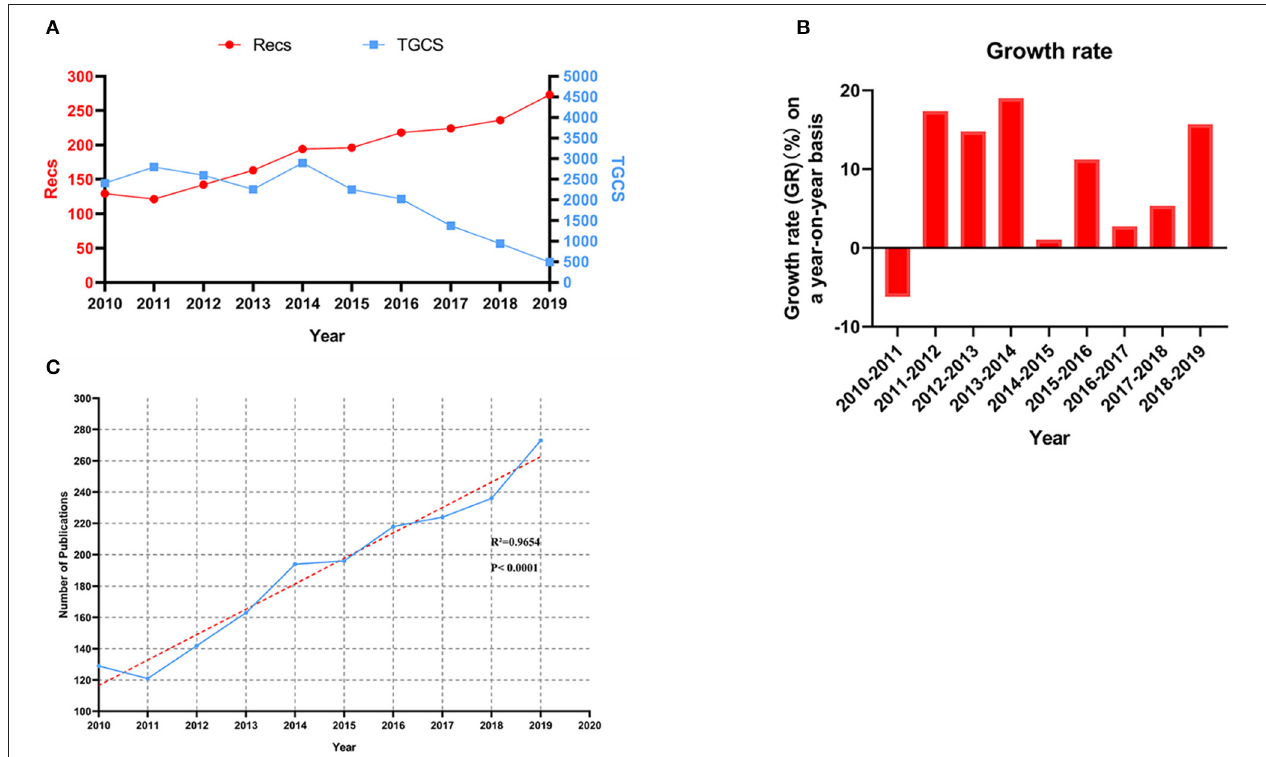
FIGURE 2 | (A,B) The annual output, citations and growth rate on a year-on-year basis with regard to MMA during 2010–2019. (C) The linear model of the upward trend in the field of MMA ( R 2 = 0.9654, P < 0.0001). Recs: Number of Records, namely the number of publications for a given year; TGCS: Total Global Citation Score, namely the total count of citations.